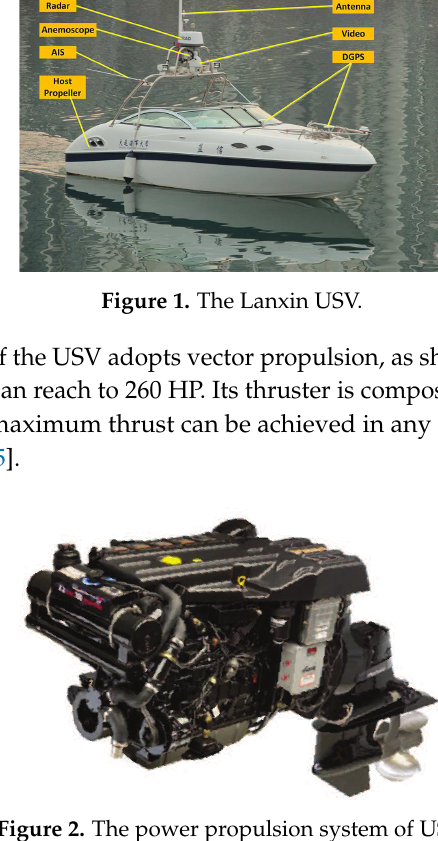
Figure 2. The power propulsion system of USV.